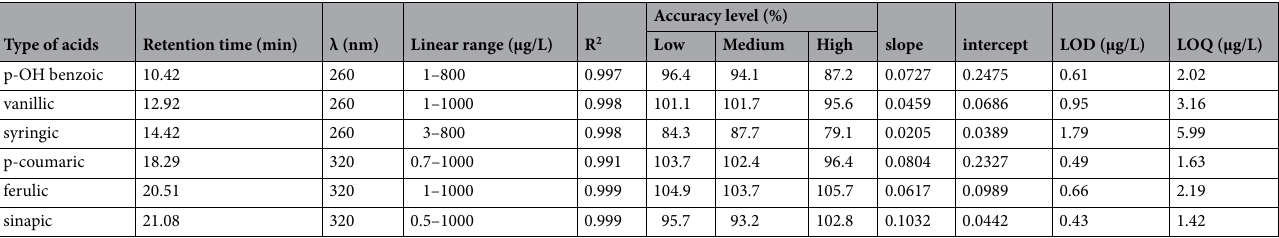
Table 1. Validation parameters.